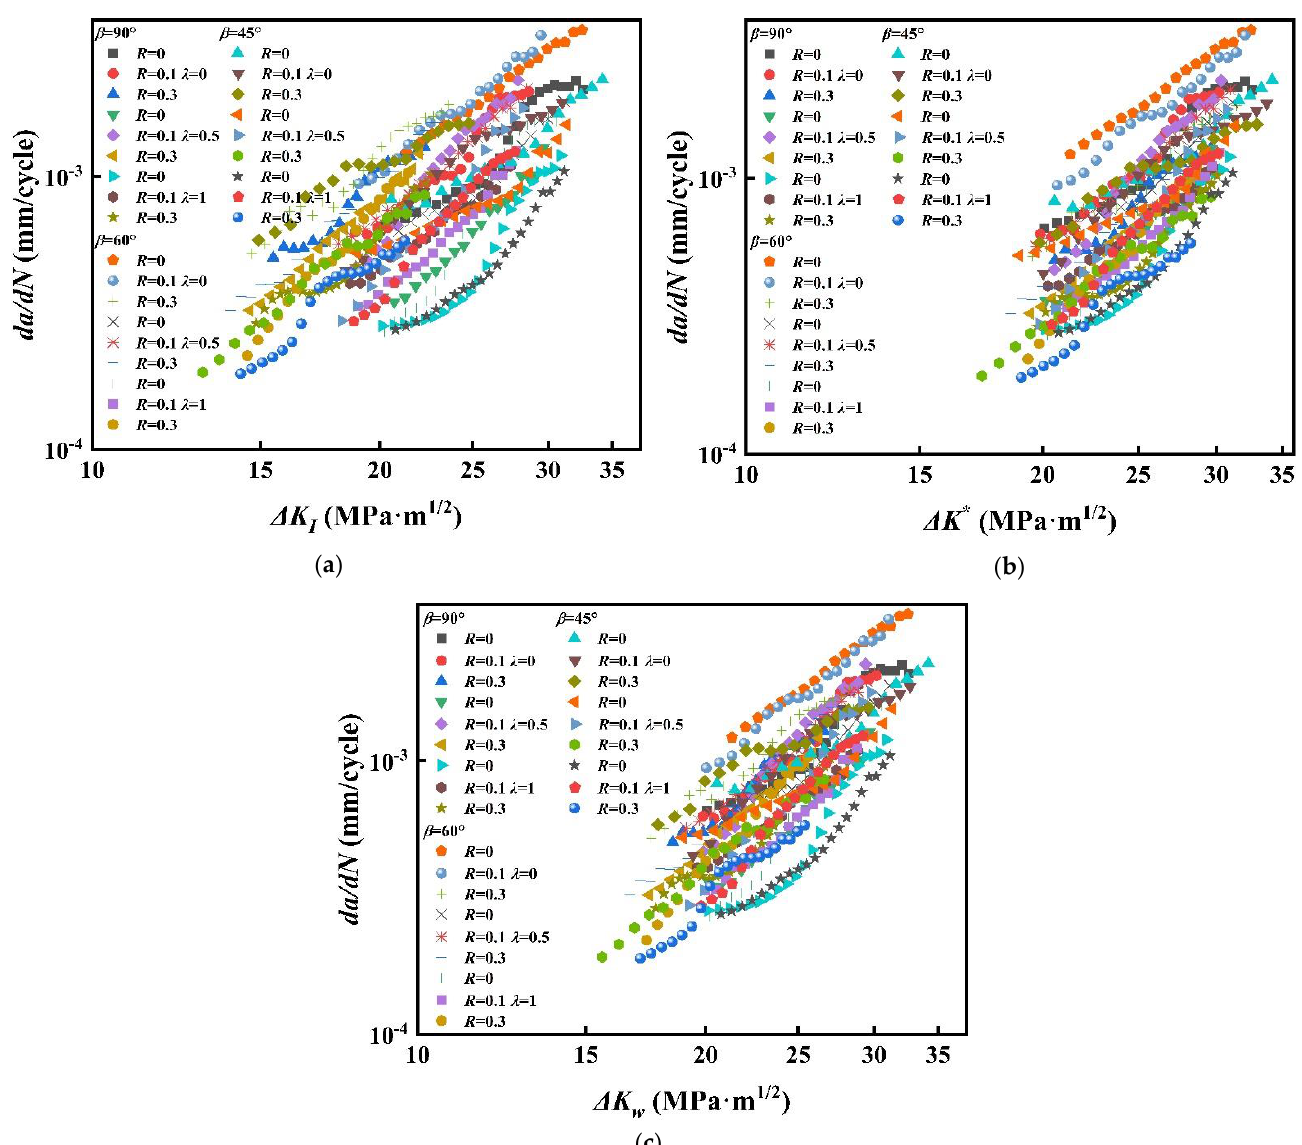
Figure 18. FCGR curve under Paris ( a ), Kujawski ( b ) and Walker ( c ) models.